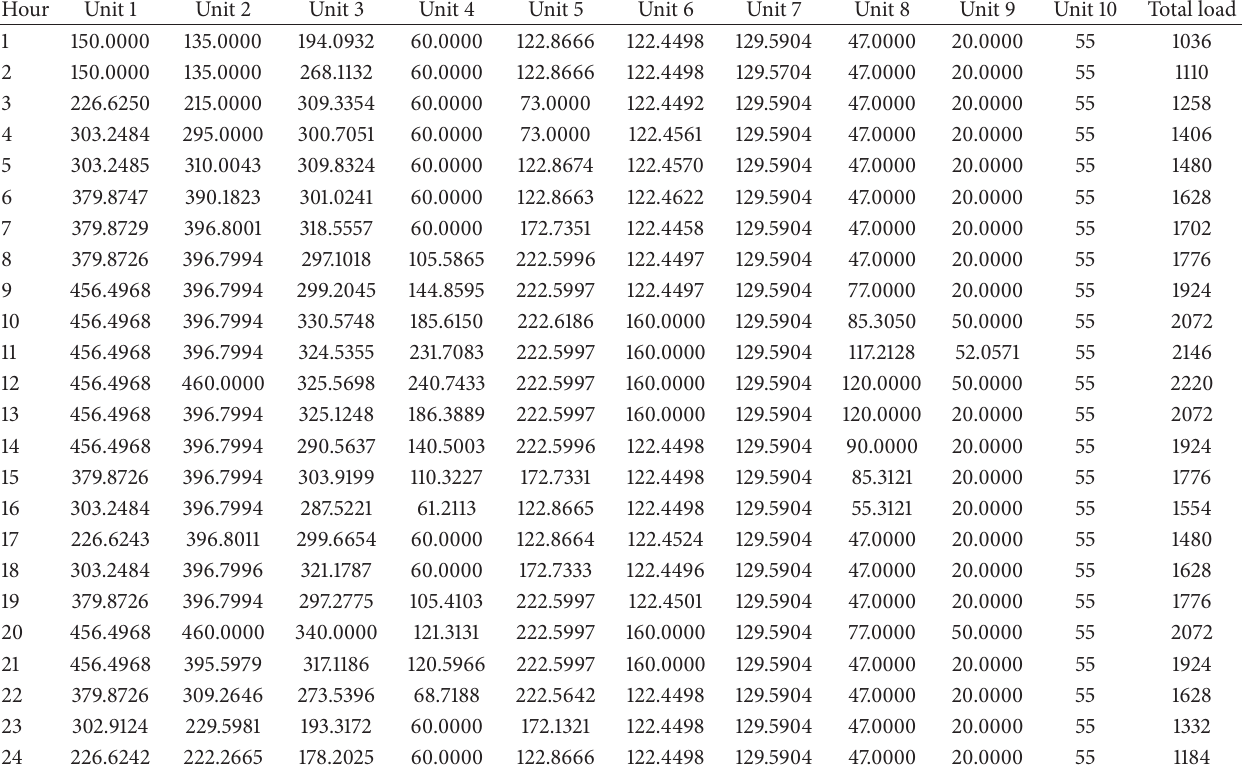
Table 3: Best solutions obtained by the proposed IDEBDSS method for test system 1